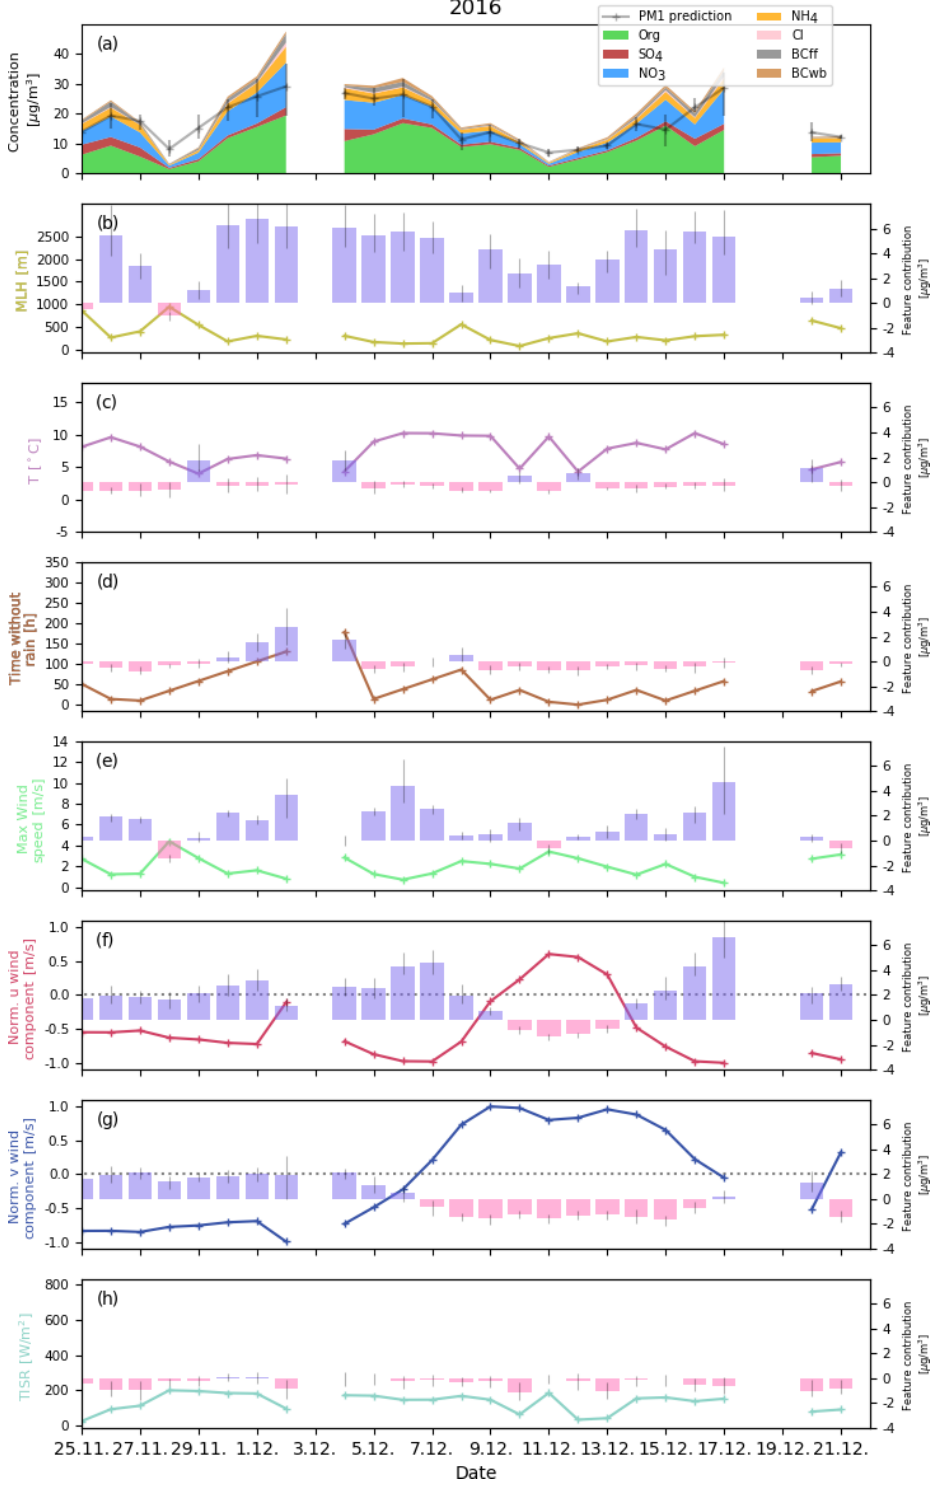
Figure 12. As Fig. 11 for a further winter pollution episode in December